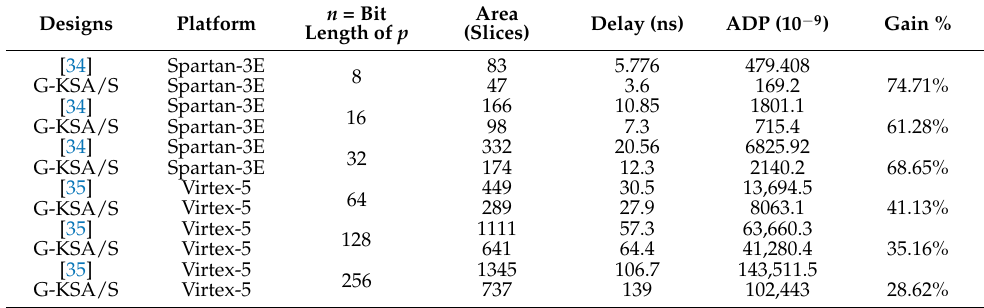
Table 3. Comparison of the proposed and existing G-KSA/S designs for different prime field lengths.